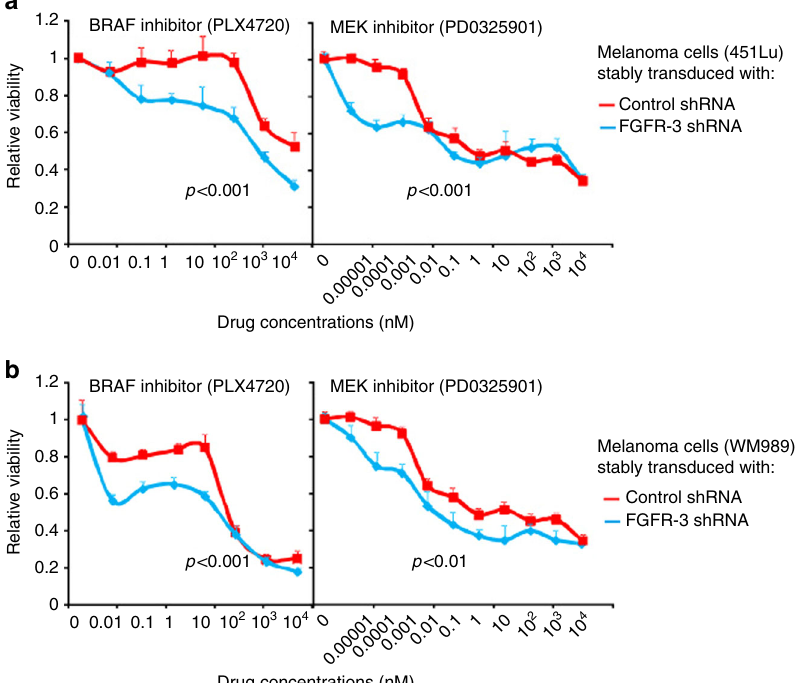
Fig. 6 Knock-down of FGFR-3 in melanoma cells restores sensitivity to signaling inhibitors. a , b Knock-down of FGFR-3 rescues the sensitivity to BRAFi and MEKi. Dose responses to BRAFi and MEKi of melanoma cell lines (451Lu ( a ) and WM989 ( b ) stably transduced with FGFR-3 shRNA ( blue lines ) were determined as in Fig. 5 and compared with control shRNA-transduction ( red lines ). For validation of the FGFR-3 shRNA clone see Supplementary Fig.